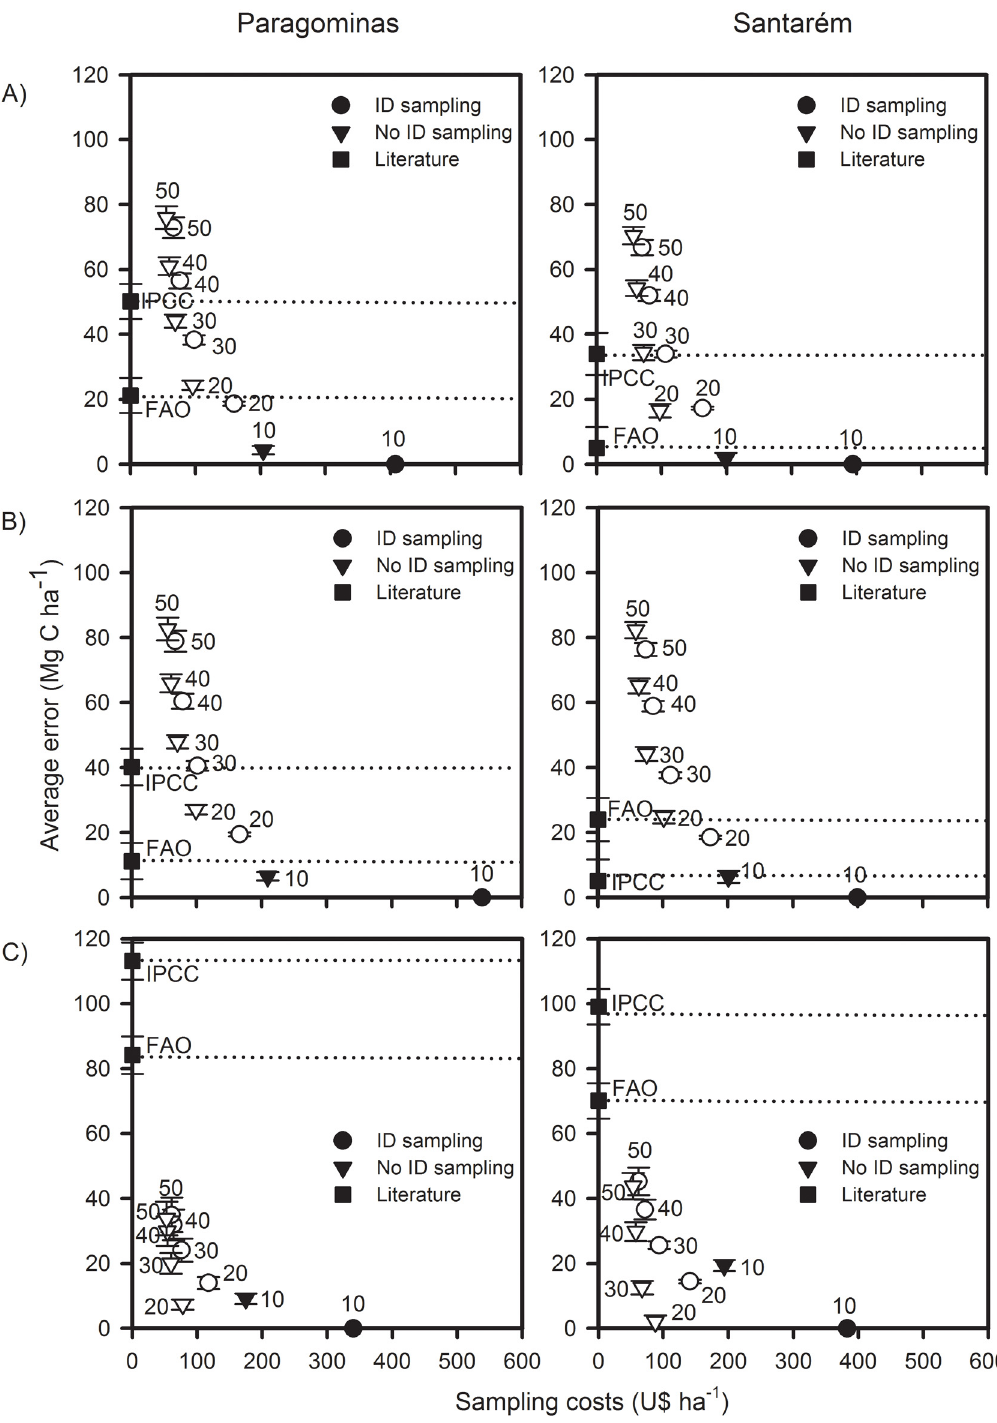
Fig 4. The costs and errors of simplifying carbon sampling protocols. Relationship between the average error of different estimates of carbon stored in large live stems and the costs of sampling a 1-ha plot. Results are separated into three hypothetical scenarios of carbon stock assessments in human- modified tropical forests: A) No a priori information of forest class; B) Primary forests only — includes undisturbed and disturbed primary forests; and C) Secondary forests only. Filled symbols indicate estimates of carbon stocks present in all stems (cid:1) 10cm DBH, whereas open symbols represent carbon estimates of subsets of large live stems. The dotted lines indicate the average error of both the IPCC and FAO estimates.